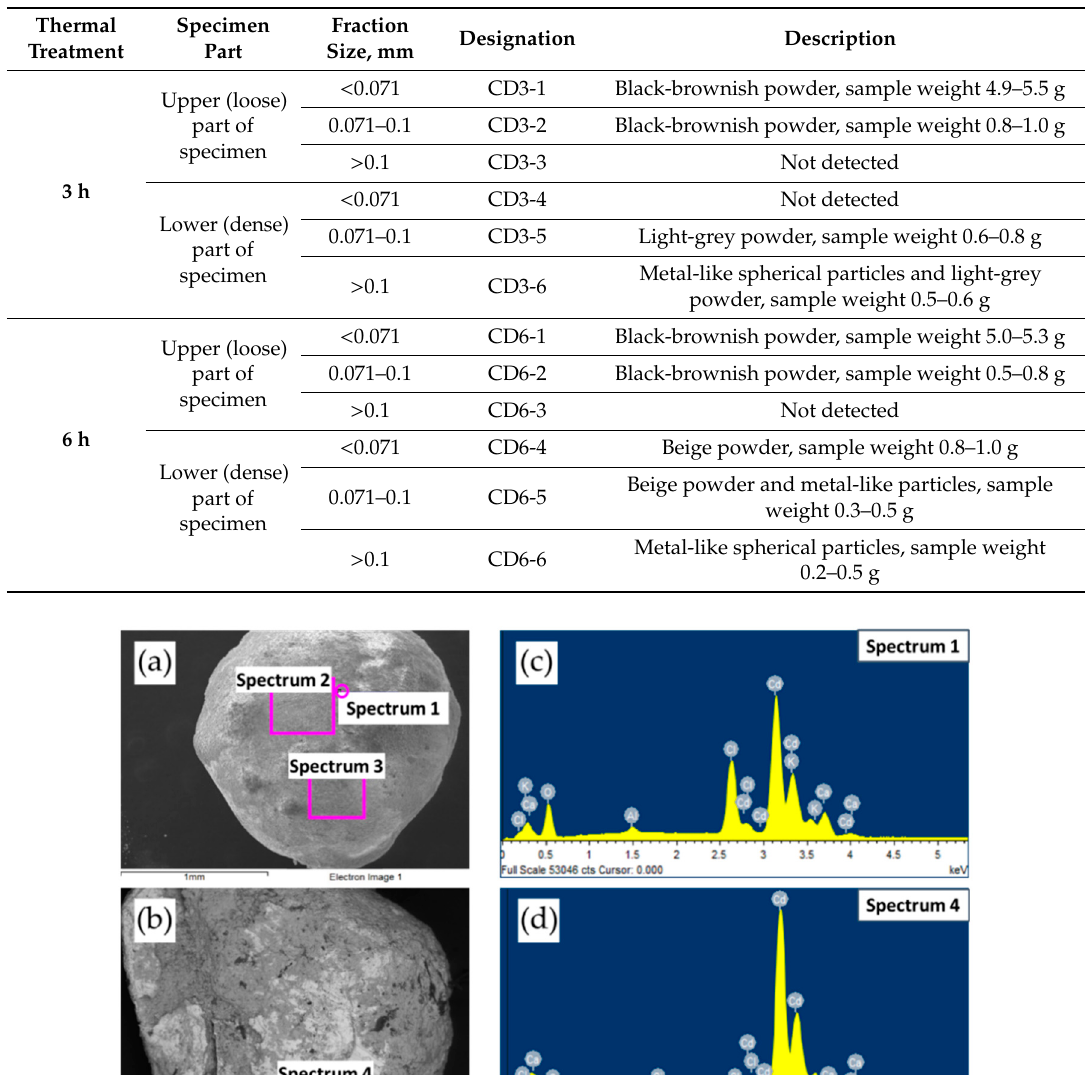
Table 1. Description and designations of samples prepared from the experiments.